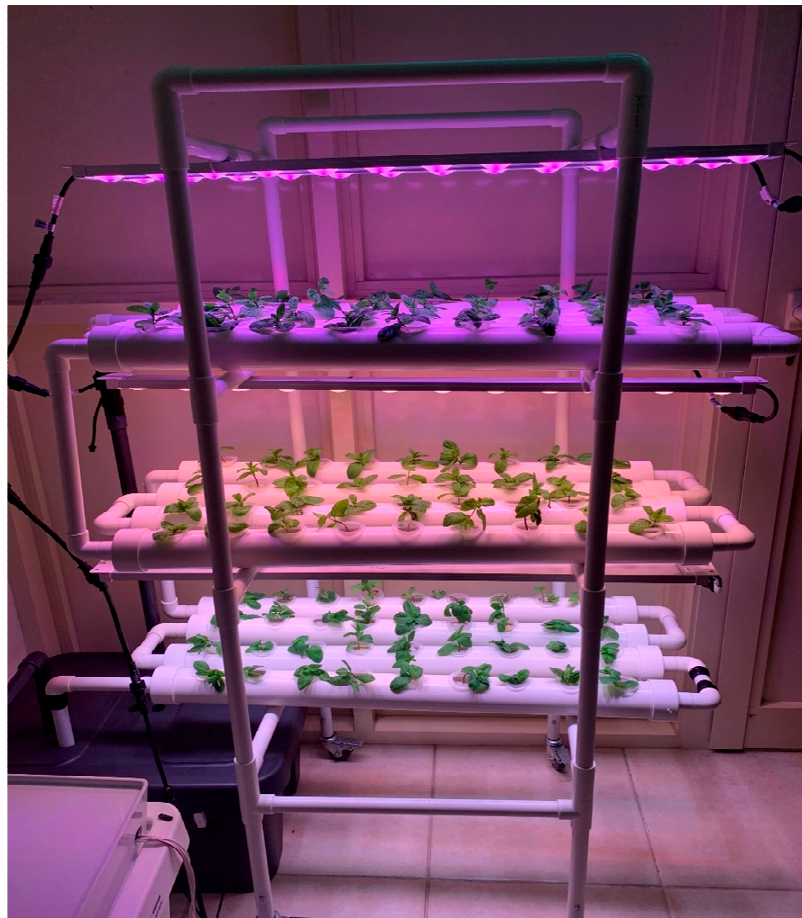
Figure 3. Vertical NFT hydroponic structure assembled and connected to the monitoring and control system.